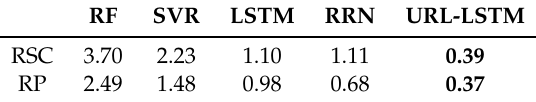
Table 3. The average MRE (%).